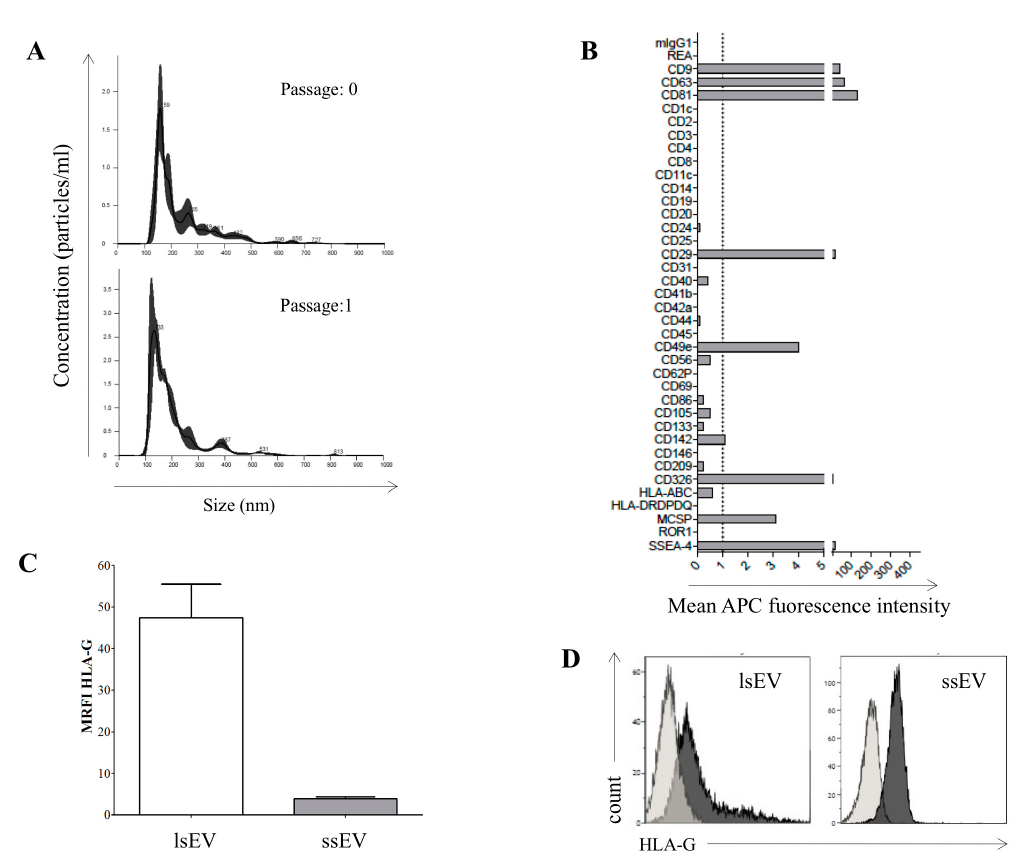
Figure 3. Expression of the membrane bound HLA-IbonhAEC-derived extracellular vesicle (EV). ( A ) Representative size distribution of EVs derived from 1 batch of hAEC at passage 0 (upper panel) and 1 (lower panel) and ( B ) representative multiplex-bead analysis for surface markers on small-size EV (ssEV) released by hAEC. ( C ) The expression of mHLA-G was evaluated by flow cytometry on large-size EV (lsEV) and on latex bead-conjugated ssEV isolated from 6 different batches of hAEC. Data are expressed as MRFI ± SE. ( D ) Representative staining for mHLA-G on hAEC-derived ssEV and lsEV. Light grey profiles indicate staining with isotype control antibodies, whereas dark grey profiles indicated staining with anti-HLA-G mAb.